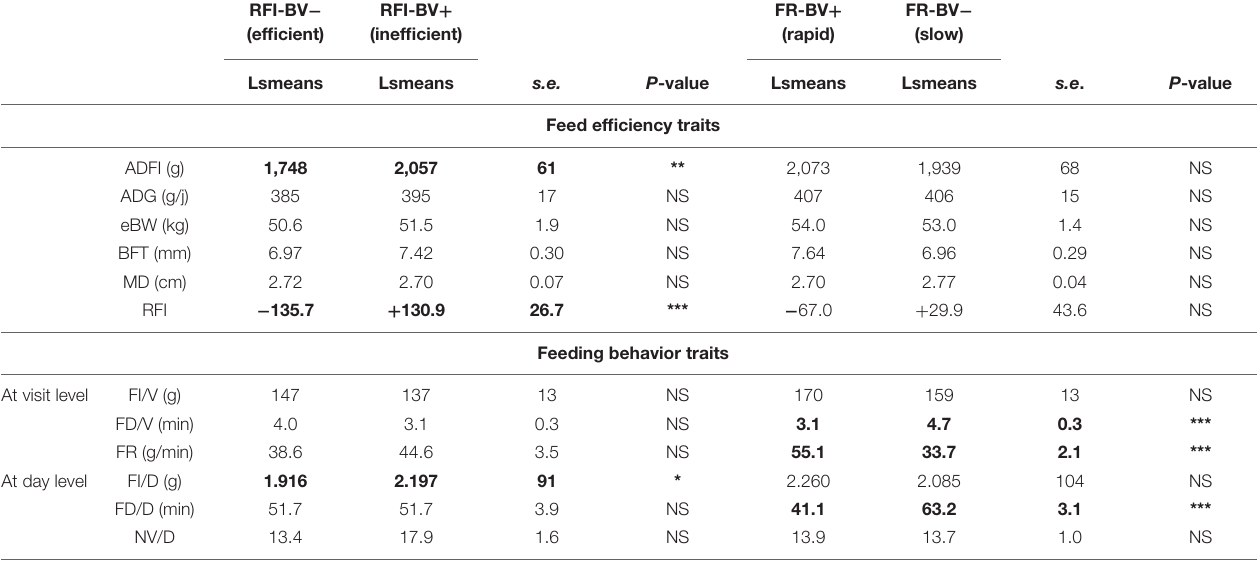
TABLE 4 | Performance and feeding behavior traits of lambs for extreme RFI index and FR index during 100% concentrates CAF period.